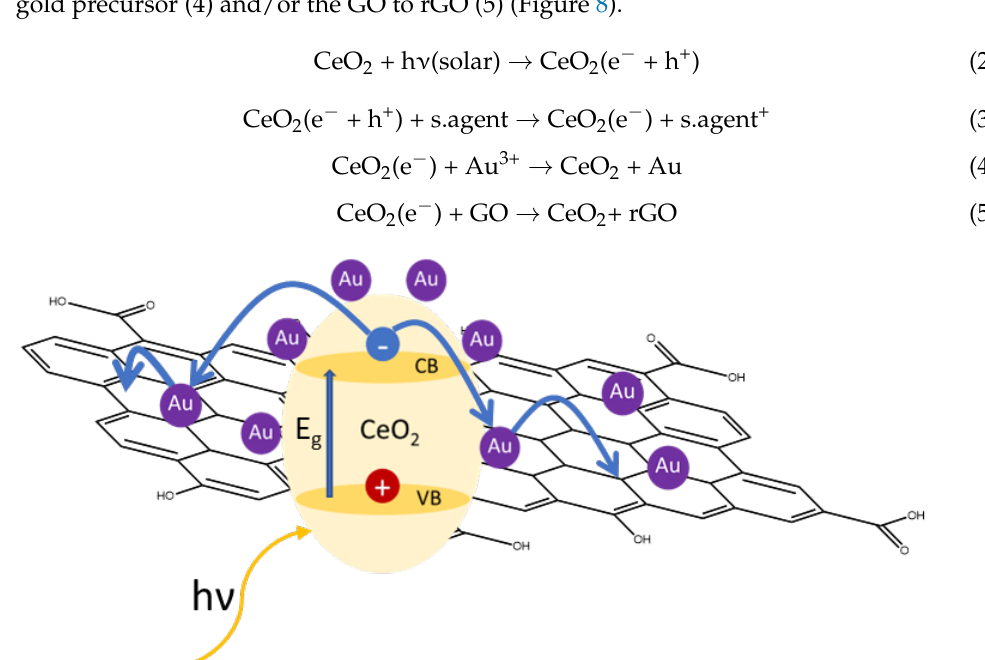
Table 3. Comparison among several CeO 2 -based systems used for the solar photocatalytic H 2 pro- duction.